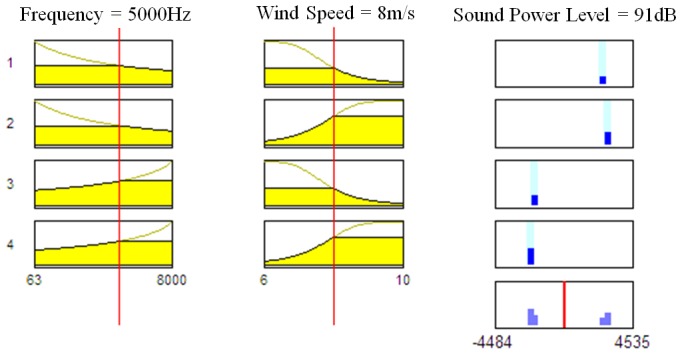
Fuzzy inference system relationship between wind speed, sound frequency and sound power level of the wind turbines.